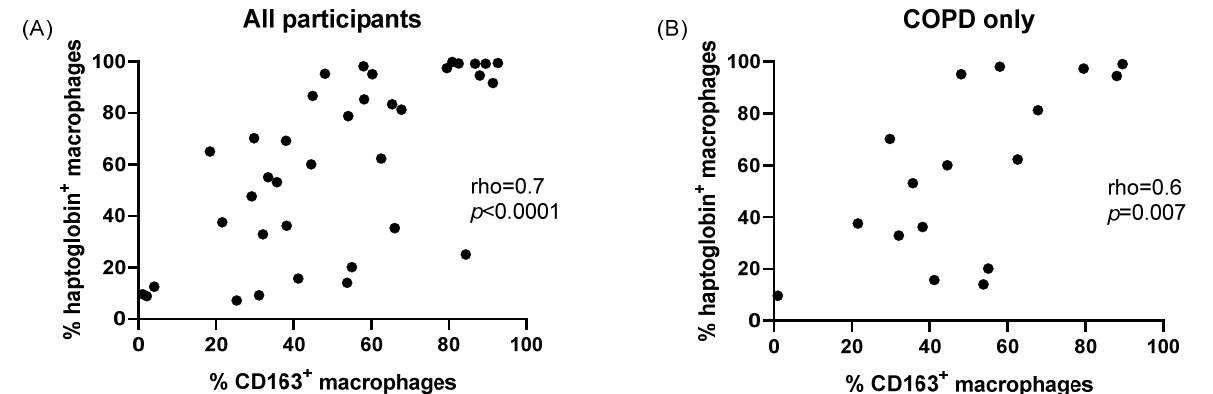
Figure 5. Relationship between haptoglobin and CD163 expression in the study population. The